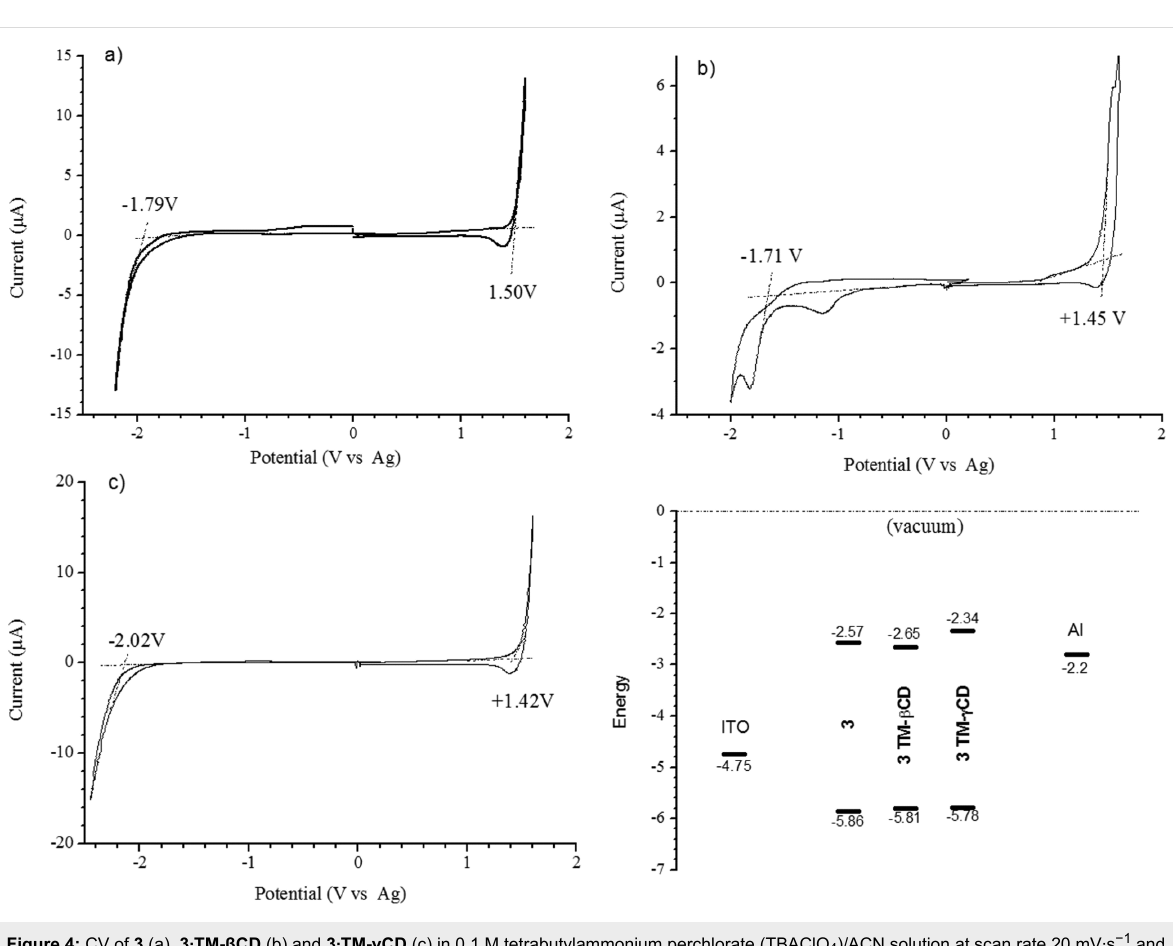
Figure 4: CV of 3 (a), 3·TM- β CD (b) and 3·TM- γ CD (c) in 0.1 M tetrabutylammonium perchlorate (TBAClO 4 )/ACN solution at scan rate 20 mV ∙ s − 1 and HOMO/LUMO energetic levels in addition to the work function of ITO (anode) and Al (cathode) (d).